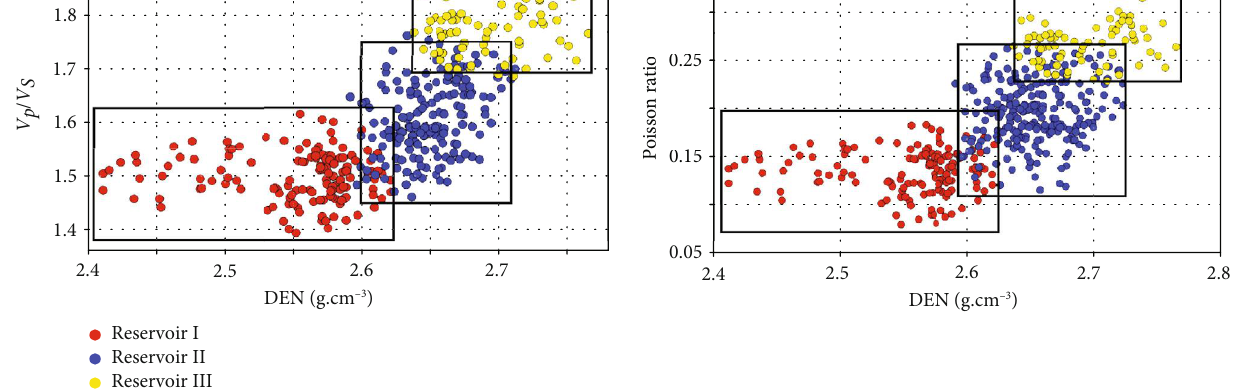
Figure 9: The di ff erent parameter intersection map of the study area.